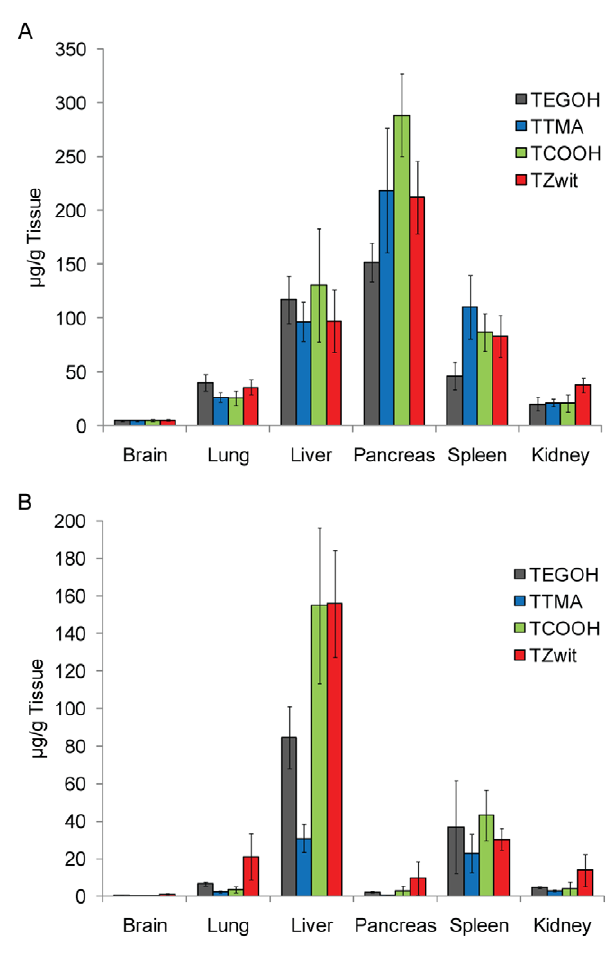
Figure 4. Tissue distribution of gold nanoparticles in mice. In vivo mean gold concentration ( m g) per gram of organ 24 hours post (A) IP injection and (B) IV injection. The mode of administration and the ligand end group of AuNPs affects the level of gold uptake in different tissues with the RES being the dominant mode of clearance. Data points are the mean + / 2 SEM from n=5 animals. Results are reported as gold concentration ( m g) per gram of organ. doi:10.1371/journal.pone.0024374.g004 PLoS ONE |